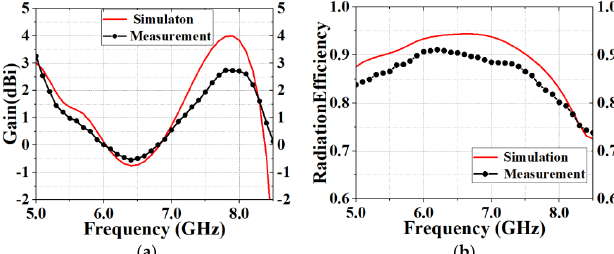
Figure 12. Comparison of simulated and measured ( a ) gain and ( b ) radiation efficiency of the designed antenna. Figure 13a–f present the 2D radiation patterns (E- and H-plane) simulated and measured at 5.8, 5.5 and 5.2 GHz, respectively. According to those figures, the antenna almost achieved omnidirectional radiation. The measurement and simulation results of the designed antenna were basically consistent.